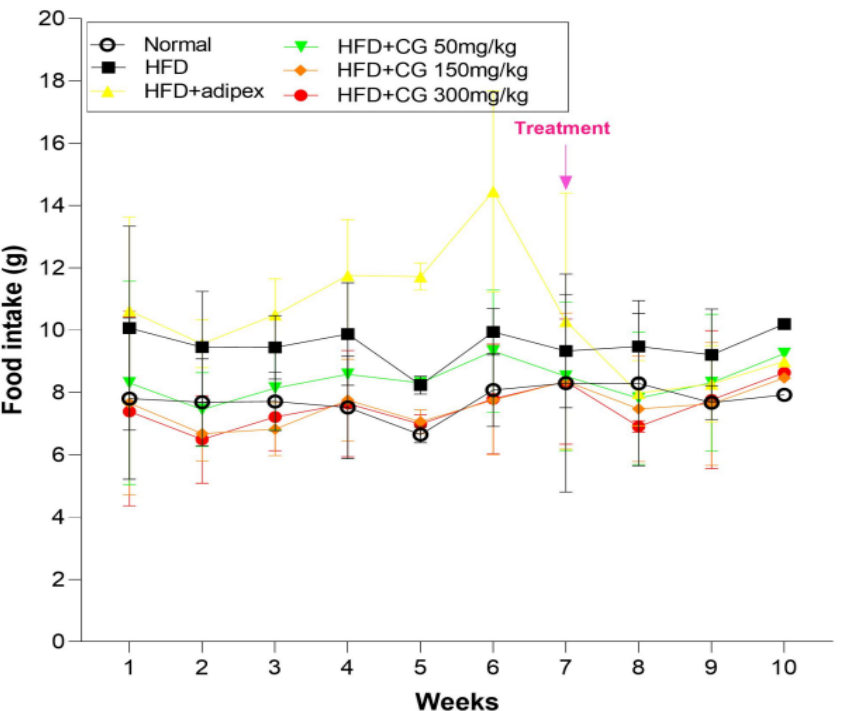
Figure 2. Change in food intake. Data represent means ± S.E.M.